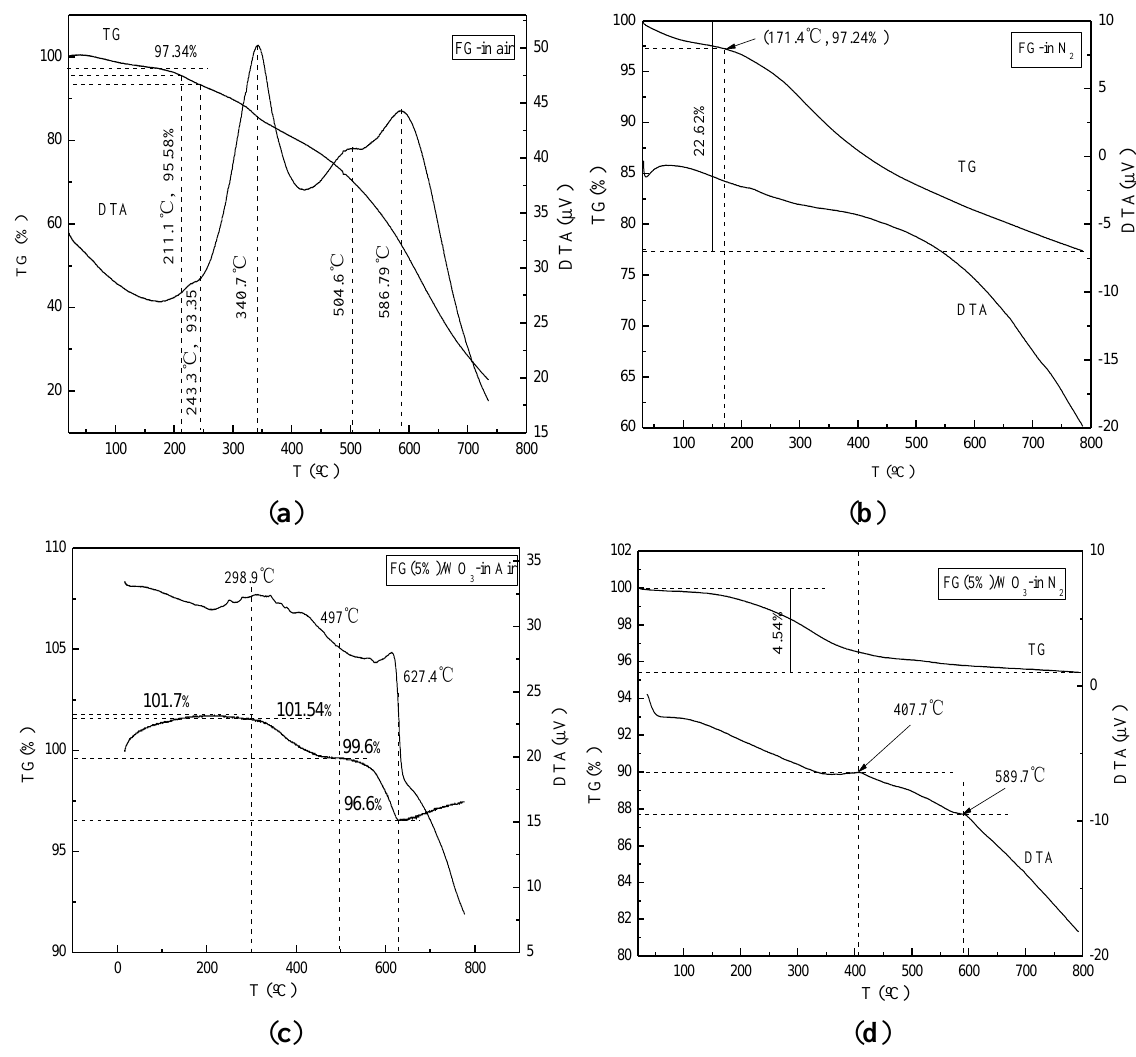
nanocomposites: ( a ) FG in 3